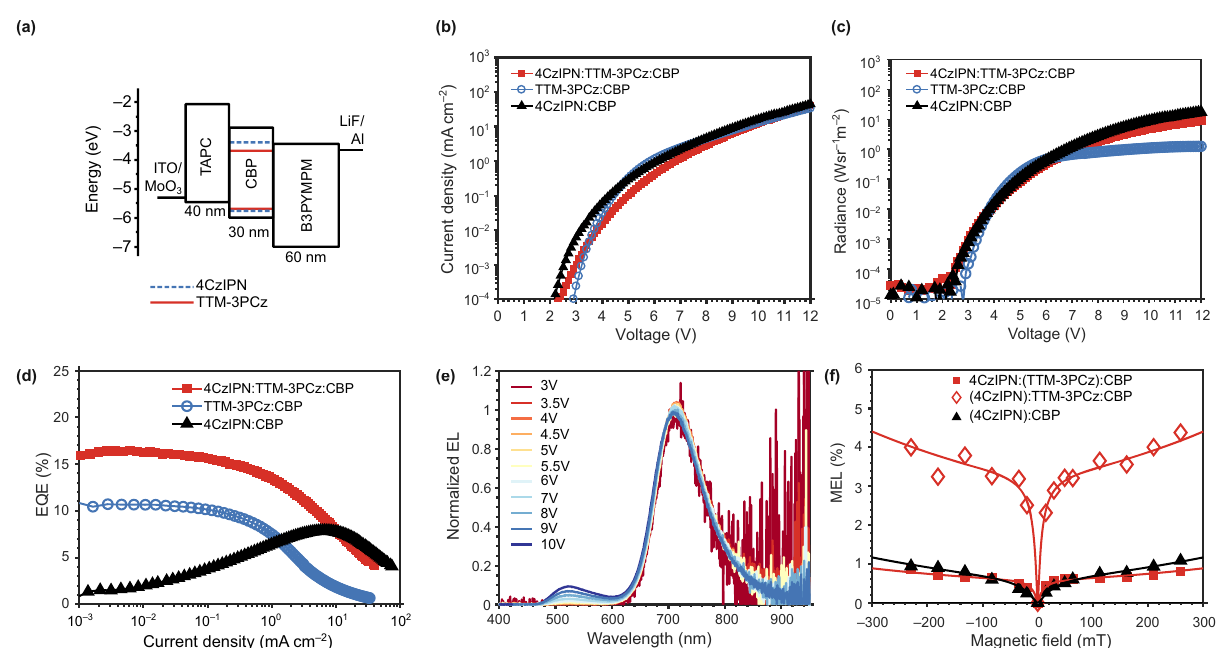
Fig. 4 4CzIPN and TTM-3PCz organic light-emitting diodes. a Device architecture for OLEDs with varying emissive layer: 4CzIPN:TTM-3PCz:CBP, 4CzIPN:CBP; TTM-3PCz:CBP. b – d Current density – voltage ( J – V ), radiance – voltage, EQE – current density (from 10 − 3 mA/cm 2 ) curves for OLEDs. e Normalised EL pro fi les for 4CzIPN:TTM-3PCz:CBP OLEDs with varying voltage, and 4CzIPN and TTM-3PCz emission contributions. f Magneto- electroluminescence (MEL) studies of TTM-3PCz (red squares) and 4CzIPN (red diamonds) emission in 4CzIPN:TTM-3PCz:CBP OLEDs; 4CzIPN emission in 4CzIPN:CBP (black triangles). OLED devices were biased at 8 V. MEL studies show different magnetic fi eld dependencies for 4CzIPN and TTM-3PCz emission from 4CzIPN:TTM-3PCz:CBP devices, which supports Dexter triplet – doublet energy transfer and not the hyper fl uorescence mechanism of 4CzIPN triplet exciton energy